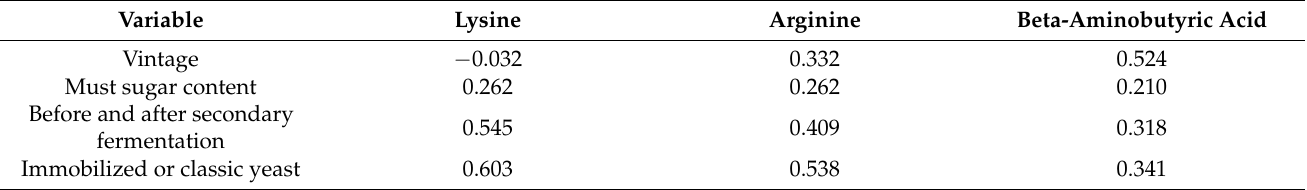
Table 2. The yeast correlation matrix comprising the secondary fermentation and yeast type with selected amino